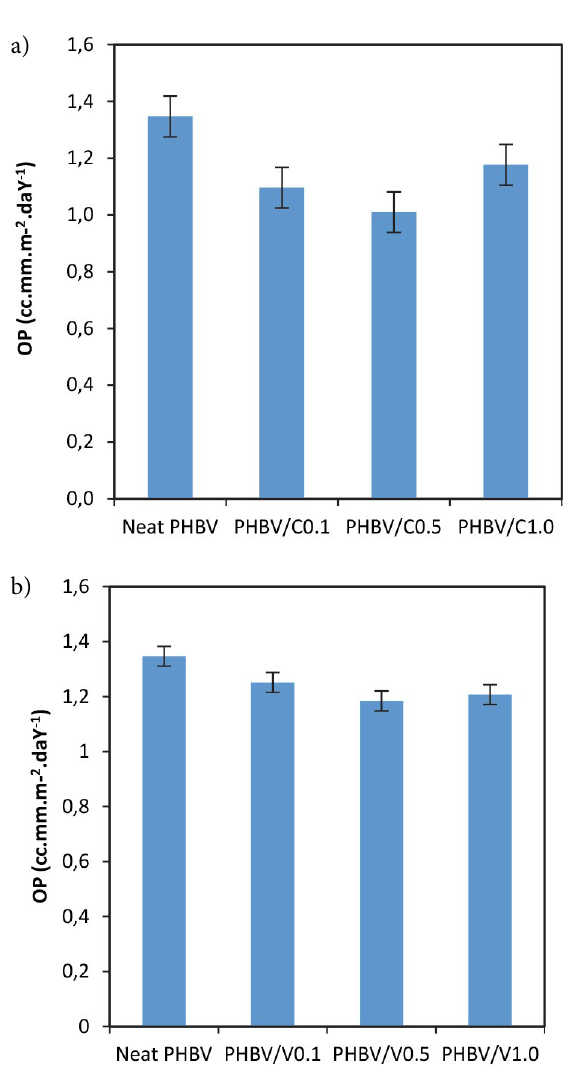
Figure 9. Oxygen permeability (OP) of neat PHBV and PHBV/CaCO 3 composites with (a) calcite and (b)